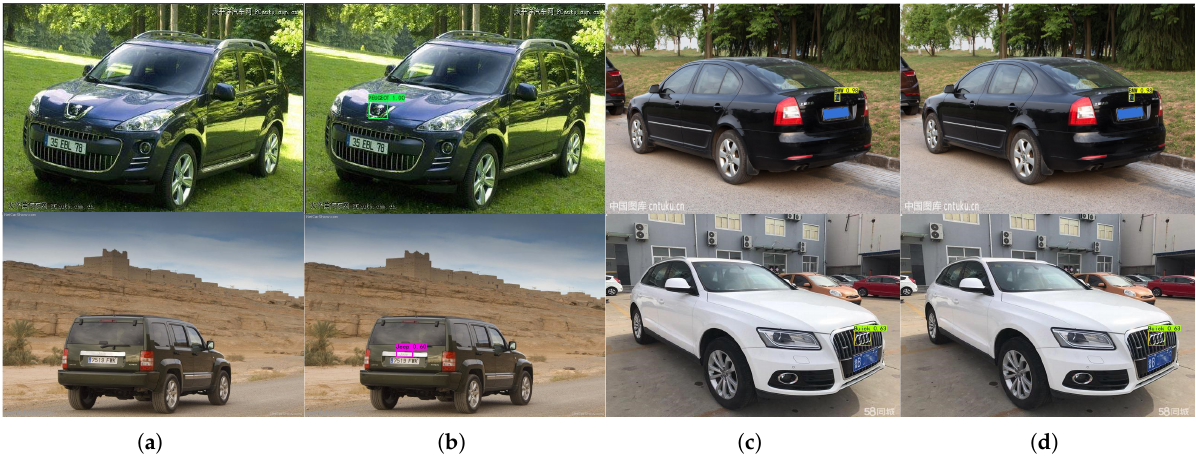
Figure 12. Comparison 3 and comparison 4 of the effect of YOLOv4 and My Model: ( a ) example 3, YOLOv4 detection results; ( b ) example 3, My Model detection results; ( c ) example 4, YOLOv4 detection results; ( d ) example 4, My model detection